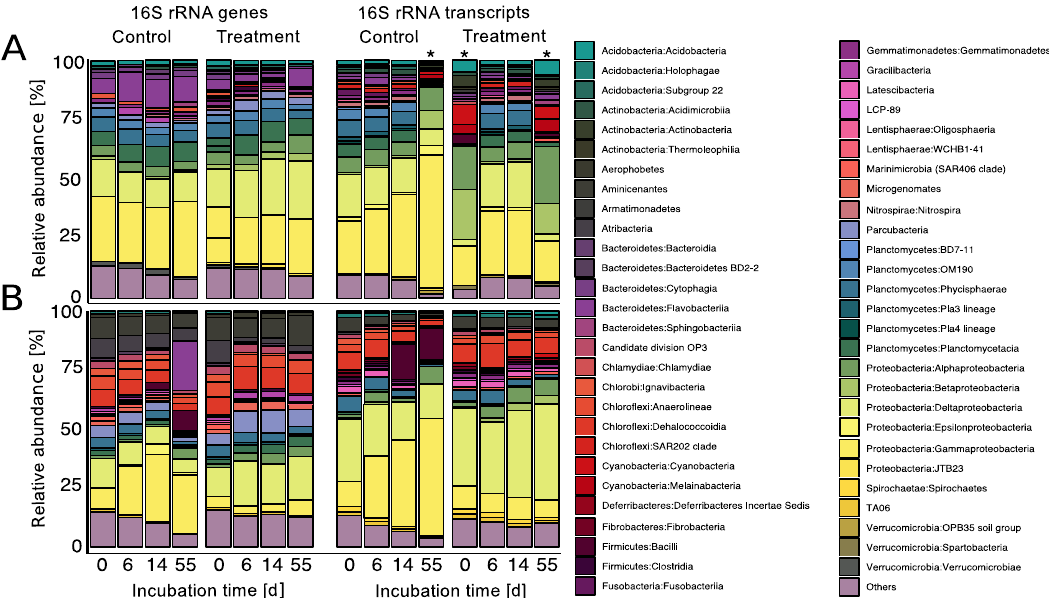
Figure 5. Relative abundances of individual taxa on class level after mitomycin C treatment compared to the non-treated controls ( A ) in the surface slurries and ( B ) 20 cmbsf slurries. DNA-based community structures are displayed on the left, RNA-based community structures on the right, both over the course of the experiment. Taxa with an average abundance < 1% throughout the experiment were summed up to “Others”. Samples with identified OTUs < 300 are marked with an asterisk (*).